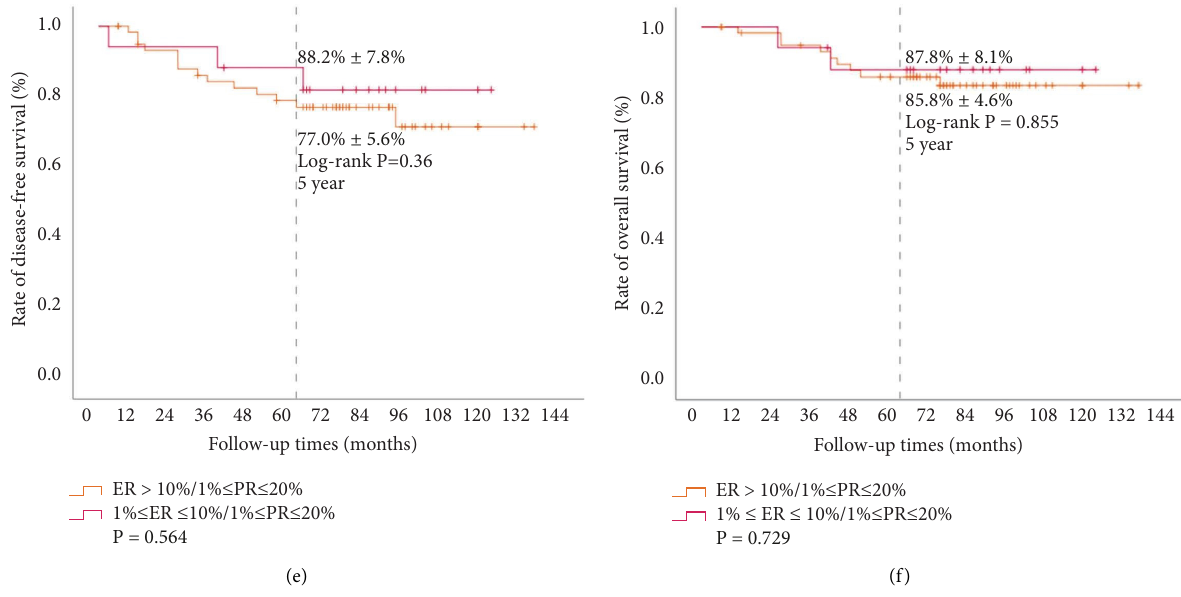
Figure 3: Survival analysis of the HH group (ER > 10%/PR > 20%), HL group (ER > 10%/1% ≤ PR ≤ 20%), and LL group (1% ≤ ER ≤ 10%/ 1% ≤ PR ≤ 20%). Kaplan–Meier survival curves were plotted, and the log rank test was performed to compare the overall survival and disease free survival among the three